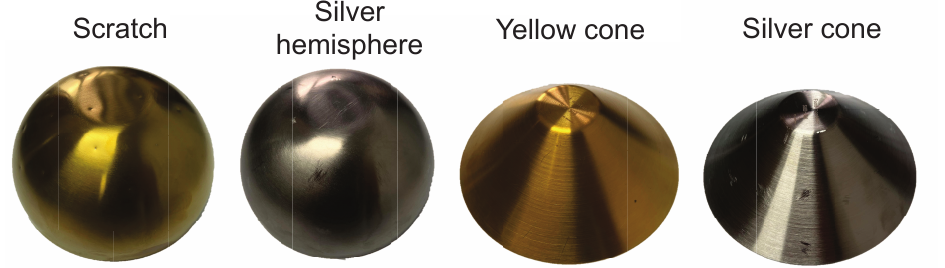
Figure 5. Objects for datasets. The dataset contained two colours (yellow and silver) and two shapes (hemisphere and cone) of objects. The material of the objects was 304 stainless steel. The two objects on the left are hemispheres with a diameter of 16 cm and a height of 5 cm. The two on the right are cones with a diameter of 15 cm and a height of 6 cm.